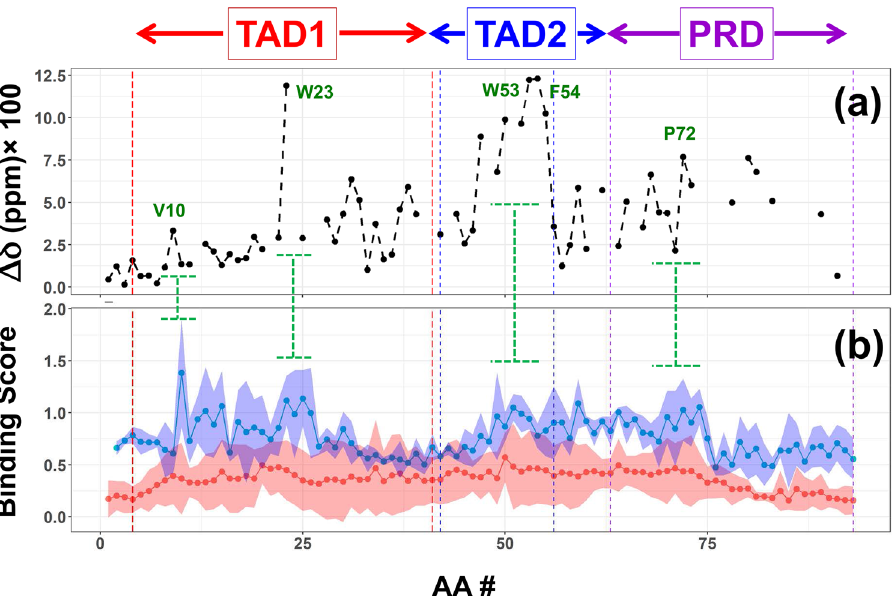
Figure 2. Comparison of the experimental chemical shift perturbation data with the binding scores. (a) Cumulative change in the chemical shifts of p53-NTD interaction with EGCG defined by weighted Euclidian distance of 15 N and 13 CO chemical shifts of the particular residue. Blanks correspond to missing experimental data. (b) A plot of the predicted binding scores of the IDP ensemble docking of p53-NTD with EGCG (blue) and the random coil ensemble of p53-NTD docking with EGCG (red). The average values of the three independently repeated measures are given by points, and the ribbons show the corresponding standard deviations of the measurements. The transcriptional activation domains (TAD1 and TAD2) and the proline-rich domain (PRD) are marked on the top. Amino acid positions that show a close match between the experimental (a) and the predicted (b) values are shown by the vertical lines